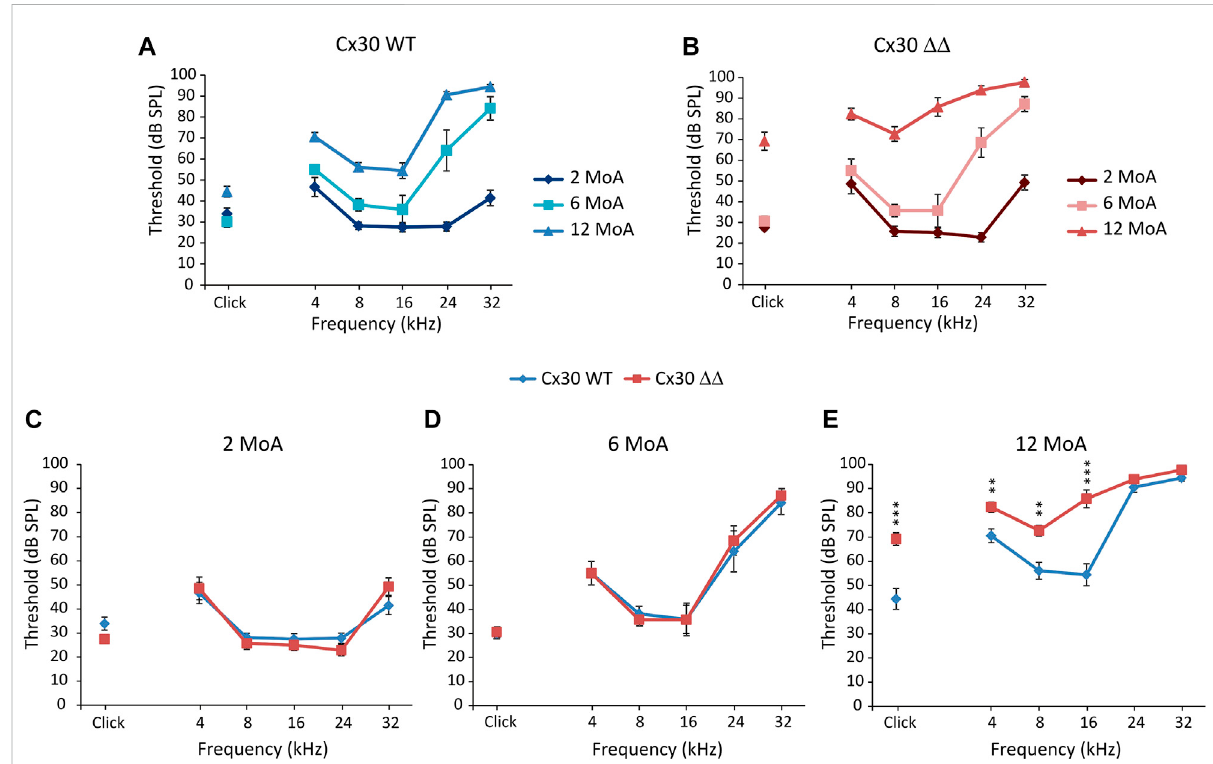
FIGURE 1 Connexin 30deletionworsensARHL. (AandB) :Graphsshow invivo auditorybrainstemrecordings(averagedthresholdvalues±standarderror of the mean, S.E.M.) with click and tone burst responses in Cx30 WT (A) and Cx30 ΔΔ mice (B) at different months of age (MoA). For statistical signi fi cance, see Supplementary Table S1. (C – E) : Comparison of auditory thresholds between Cx30 WT (blue diamonds) and Cx30 ΔΔ (red